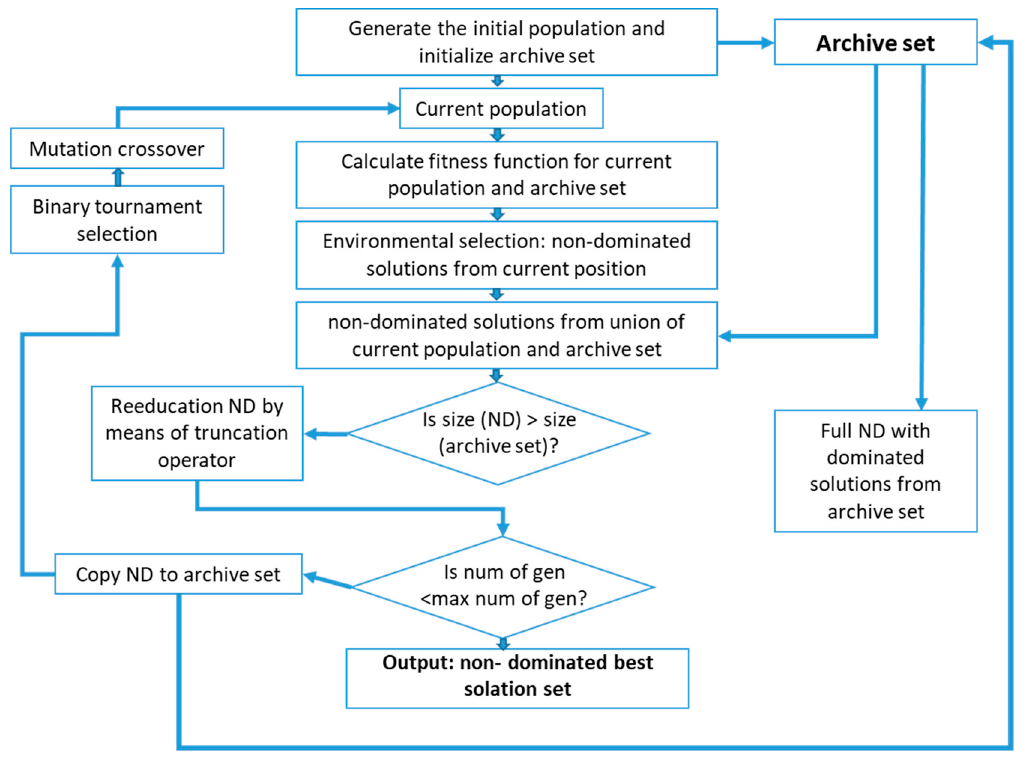
Figure 4. Optimization process in the SPEA2 algorithm.